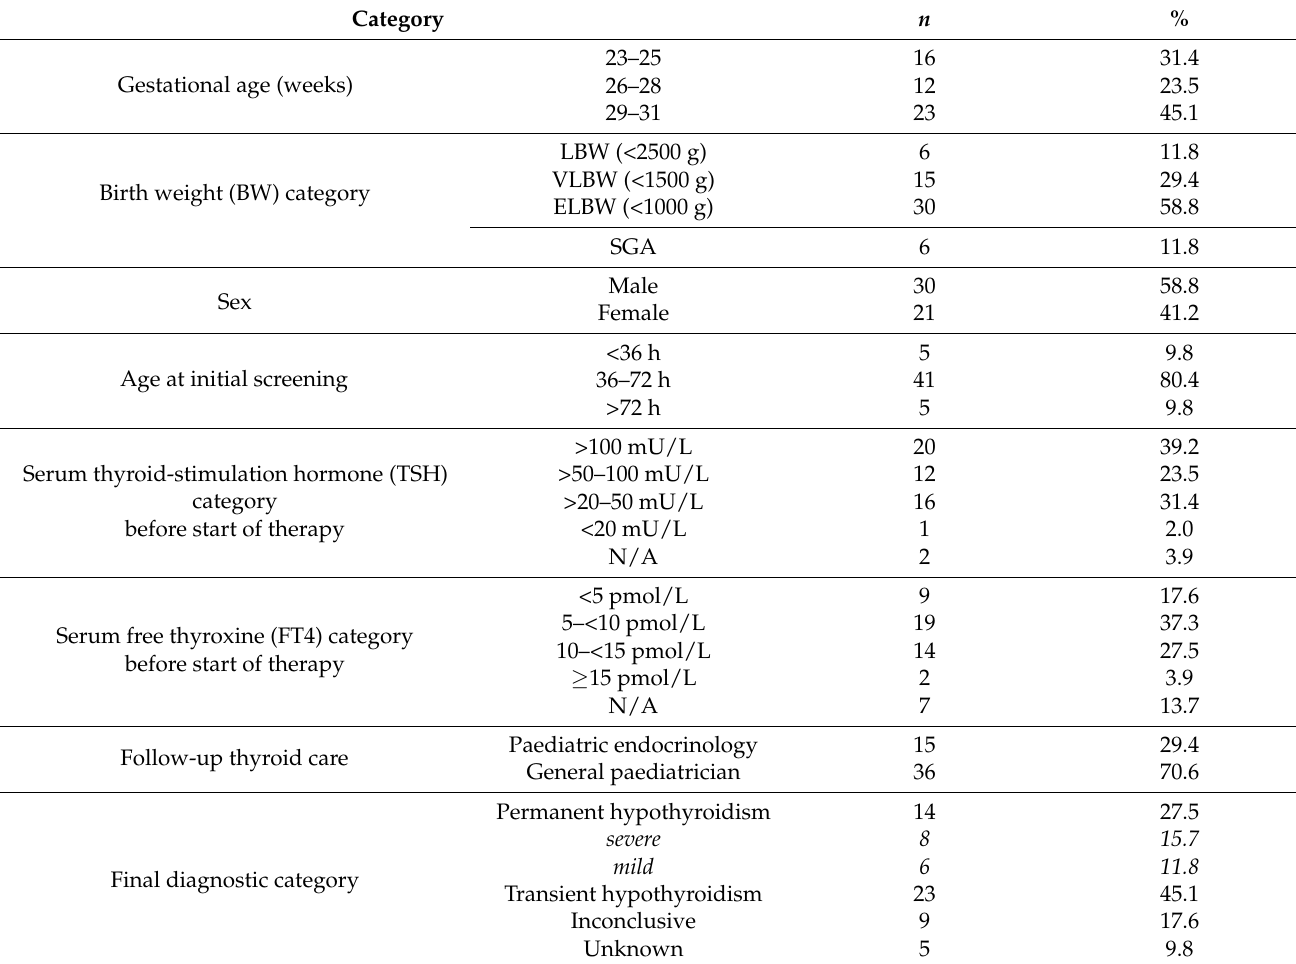
Table 1. Main population characteristics and results.